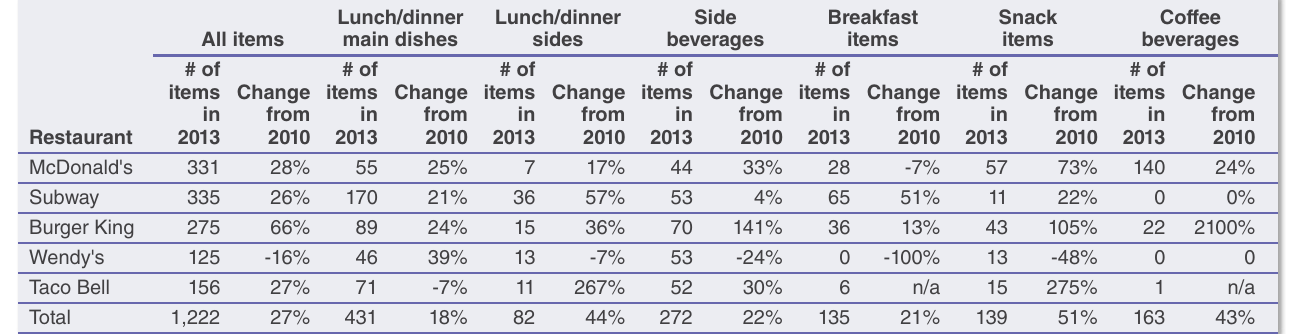
Table 8. Number of menu items per restaurant